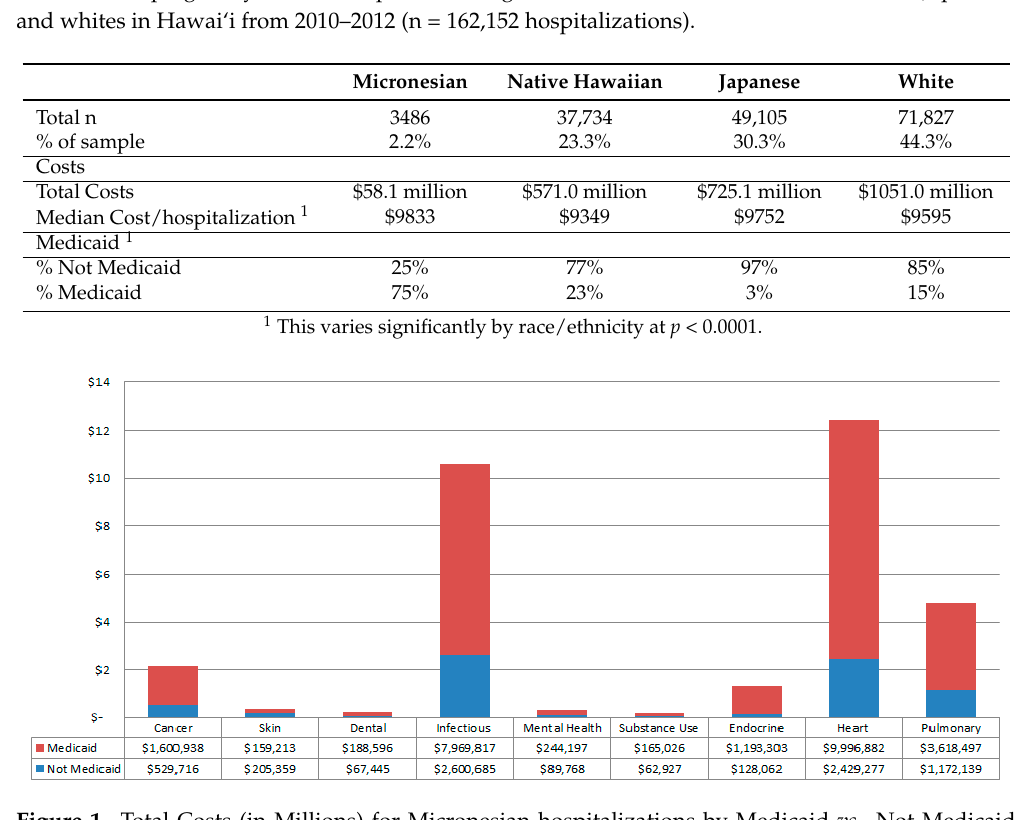
Figure 1. Total Costs (in Millions) for Micronesian hospitalizations by Medicaid vs. Not Medicaid by All Patient Refined Diagnosis Related Groups hospitalization types from 2010 to 2012 Hawaii Health Information Corporation Data. The amount paid by Medicaid for each type is noted. (n = 3486 Micronesian hospitalizations). Specific percentages as paid by Medicaid by disease type are as follows: 75% Cancer, 44% Skin, 74% Dental, 75% Infectious, 73% Mental Health, 72% Substance Use, 90% Endocrine, 80% Heart Disease, and 76%